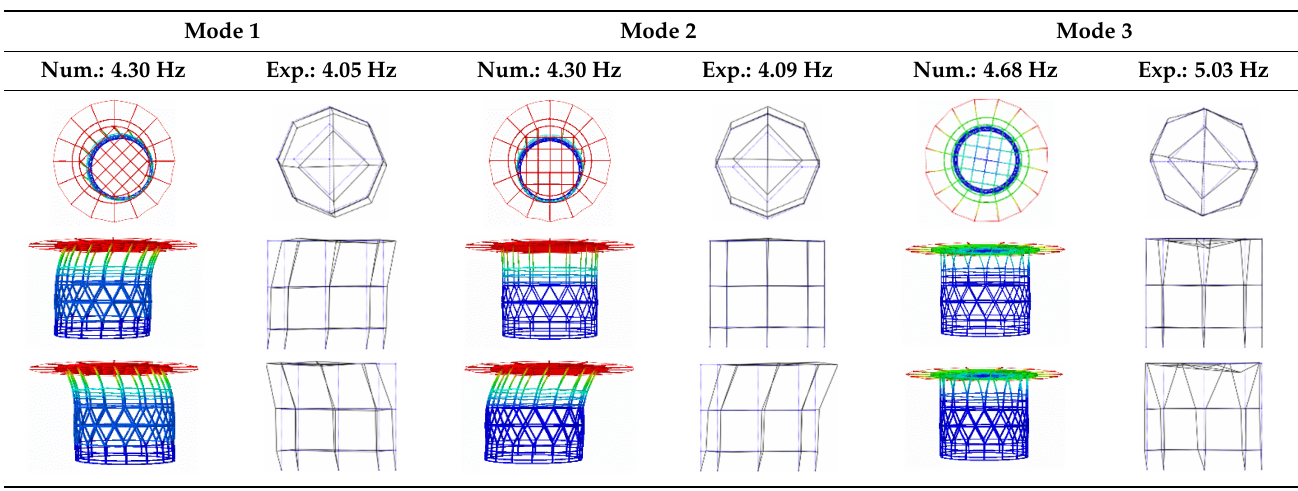
Figure 19. Acceleration time history for mallet impact excitation. Table 4. Result of numerical and experimental modal analysis of the Bishop Rock lighthouse helideck for its first three vibration modes (the contours of showing the displacement magnitude where dark blue refers to zero and red indicates displacement equal or greater than 1